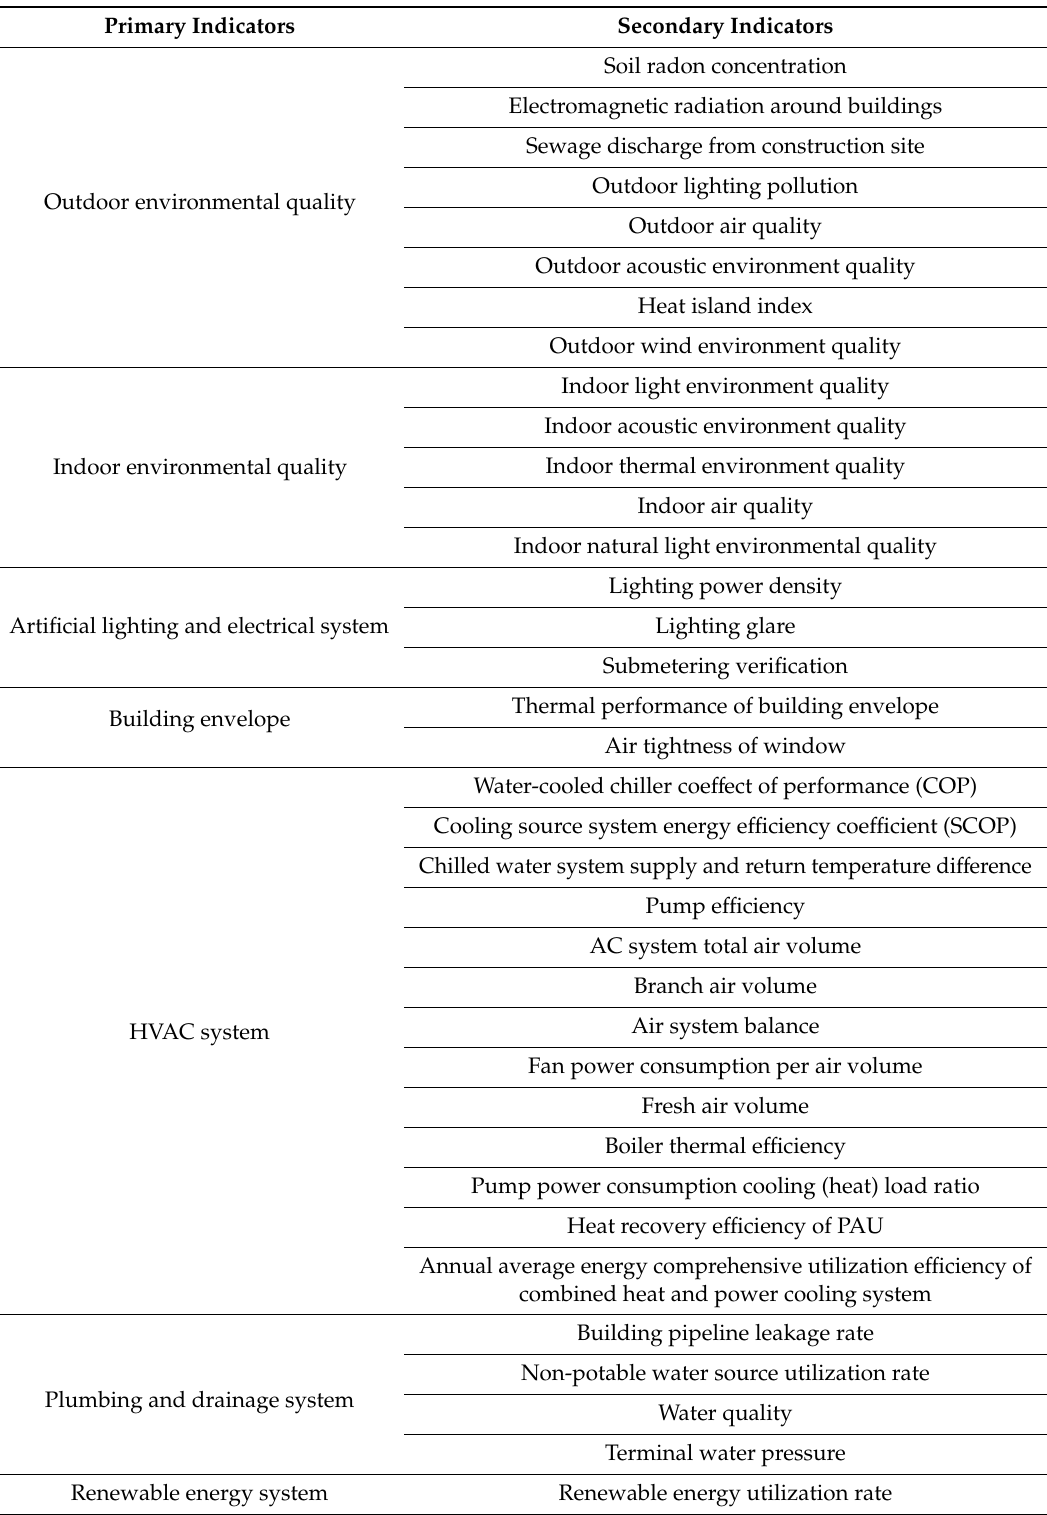
Table 8. Primary and secondary indicators proposed by standard and regulation